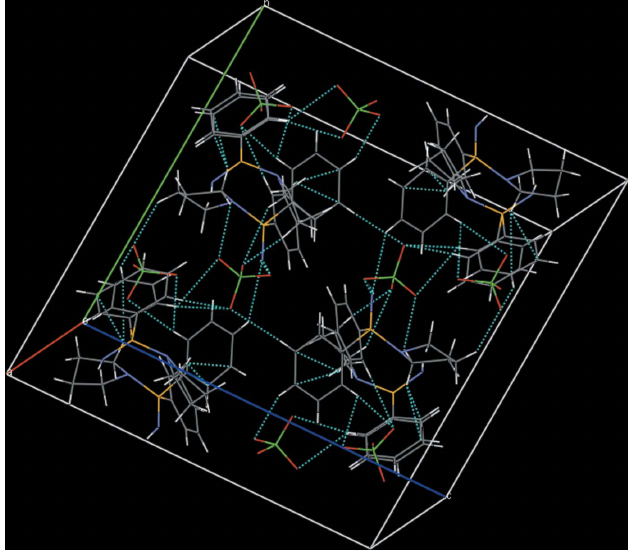
Figure 2 A packing view of the title compound, showing N—H (cid:2)(cid:2)(cid:2) O, C—H (cid:2)(cid:2)(cid:2) O, and C—H (cid:2)(cid:2)(cid:2) N hydrogen bonds (dashed lines).